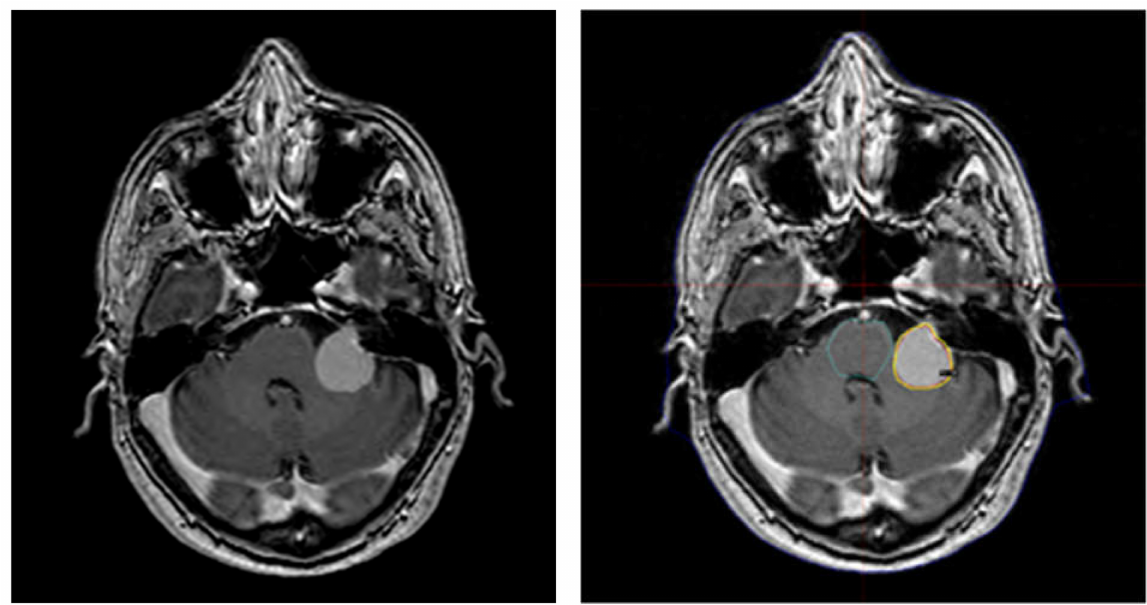
Figure 2. Left: MRI showing the enhancement post-gadolinium administration. Right: MRI of the brain to contour the tumor on 1.5T clinical scanners (Philips Achiva, Best, The Netherlands) used in the planning stage with gamma plan station. Images were transferred to the gamma plan working station. The tumor showed a volume of 5514 cm 3 . Treatment was delivered by the Leksell Gamma Knife Icon TM (Elekta, Stockholm, Sweden) as a single dose with 13 Gy marginal dose, 50%